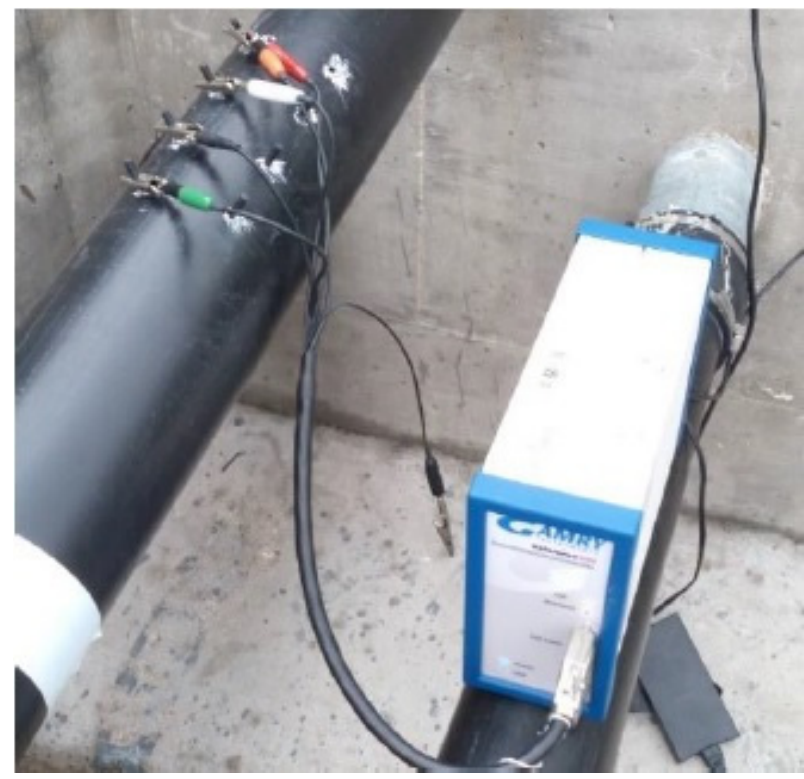
Figure 6. Electrochemical impedance spectrometer [9].